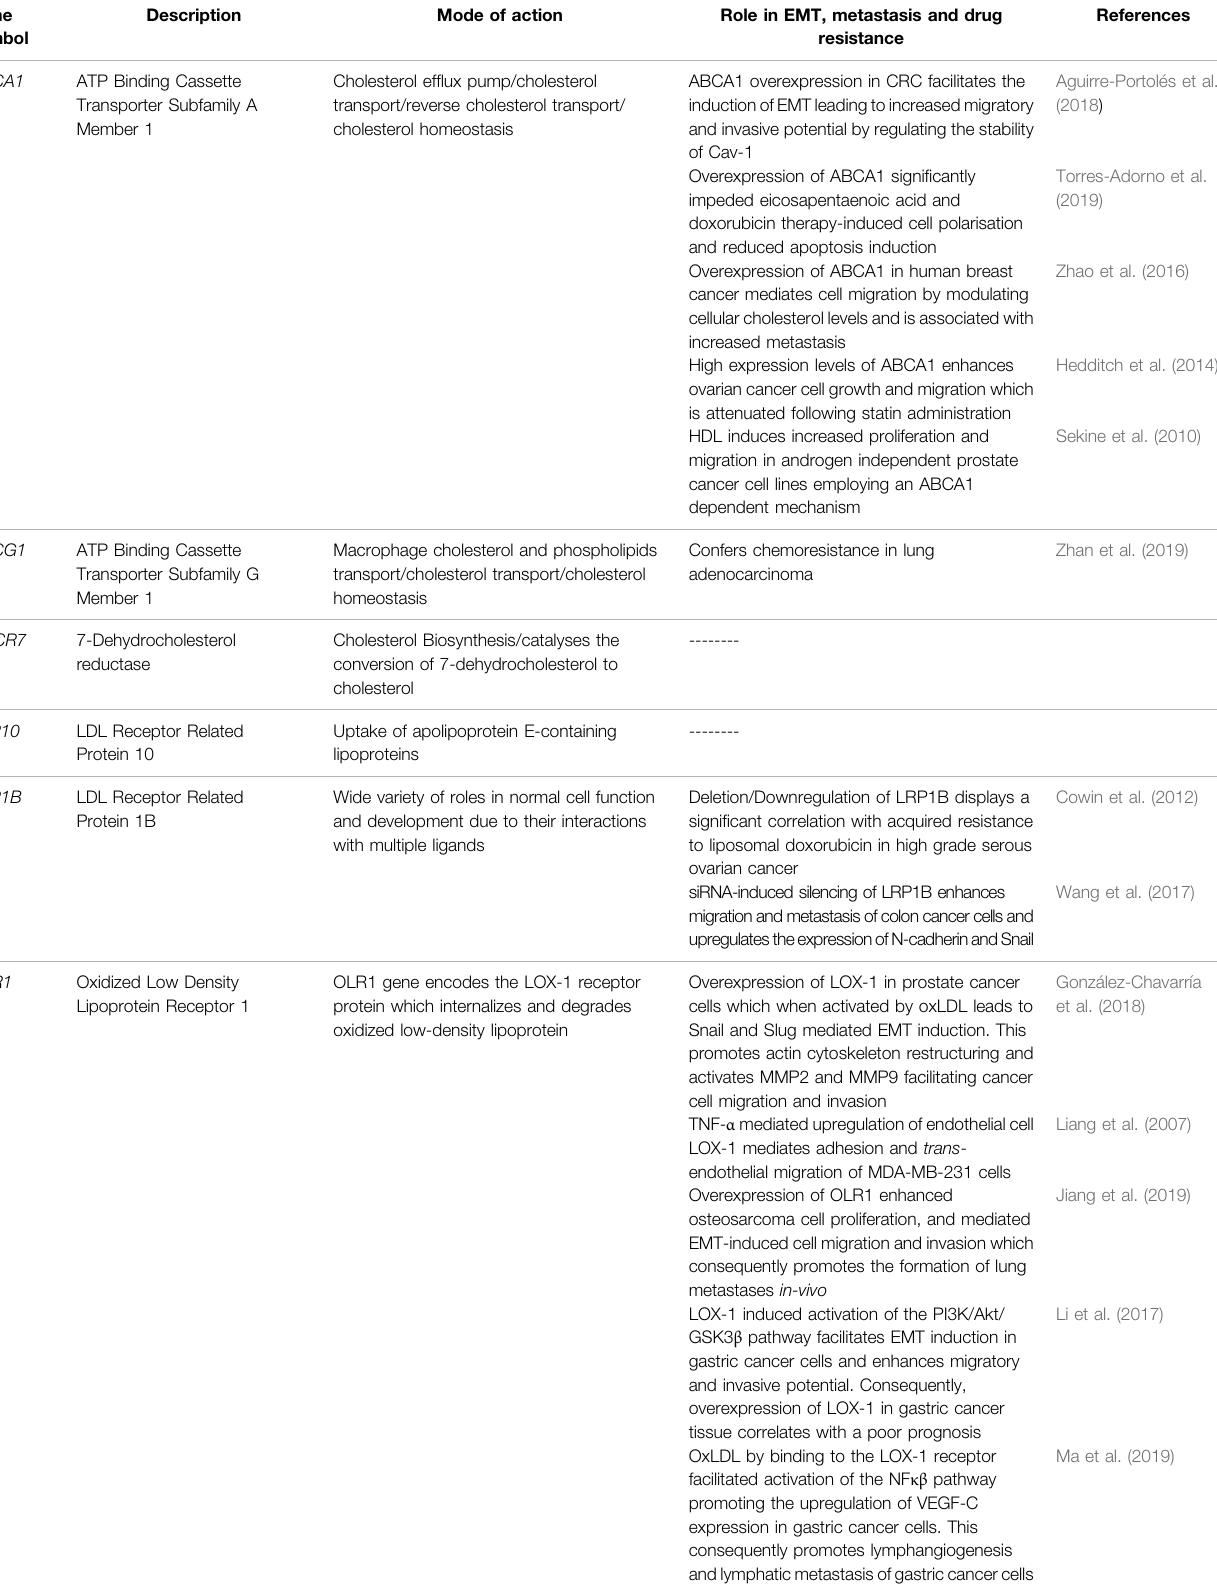
TABLE 1 | Summary of cholesterol related genes and their link to EMT, metastasis and drug